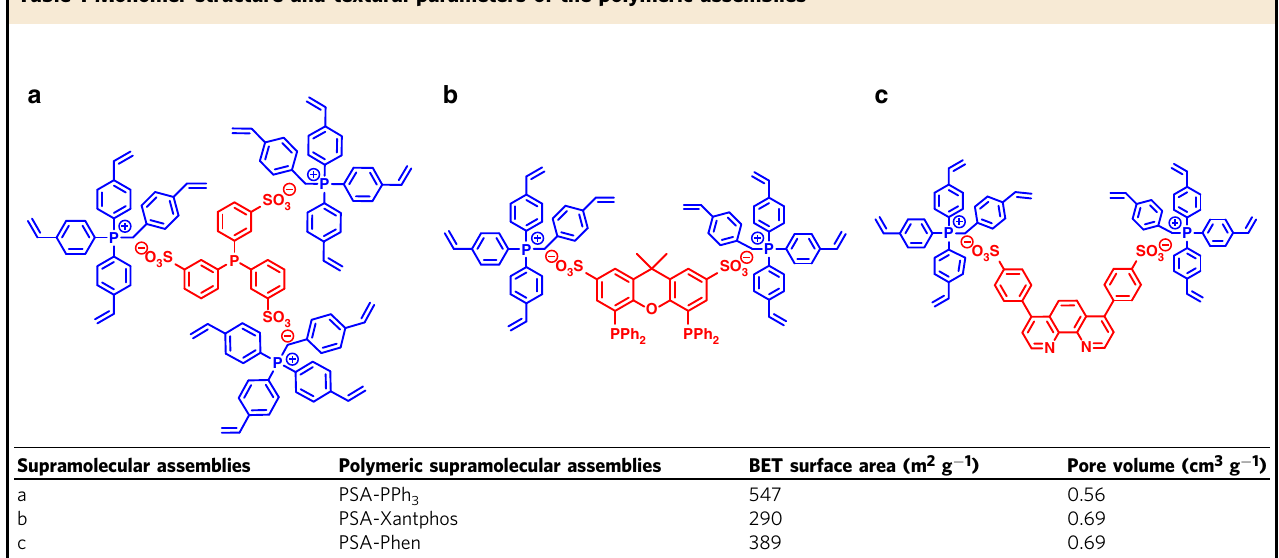
Table 1 Monomer structure and textural parameters of the polymeric assemblies